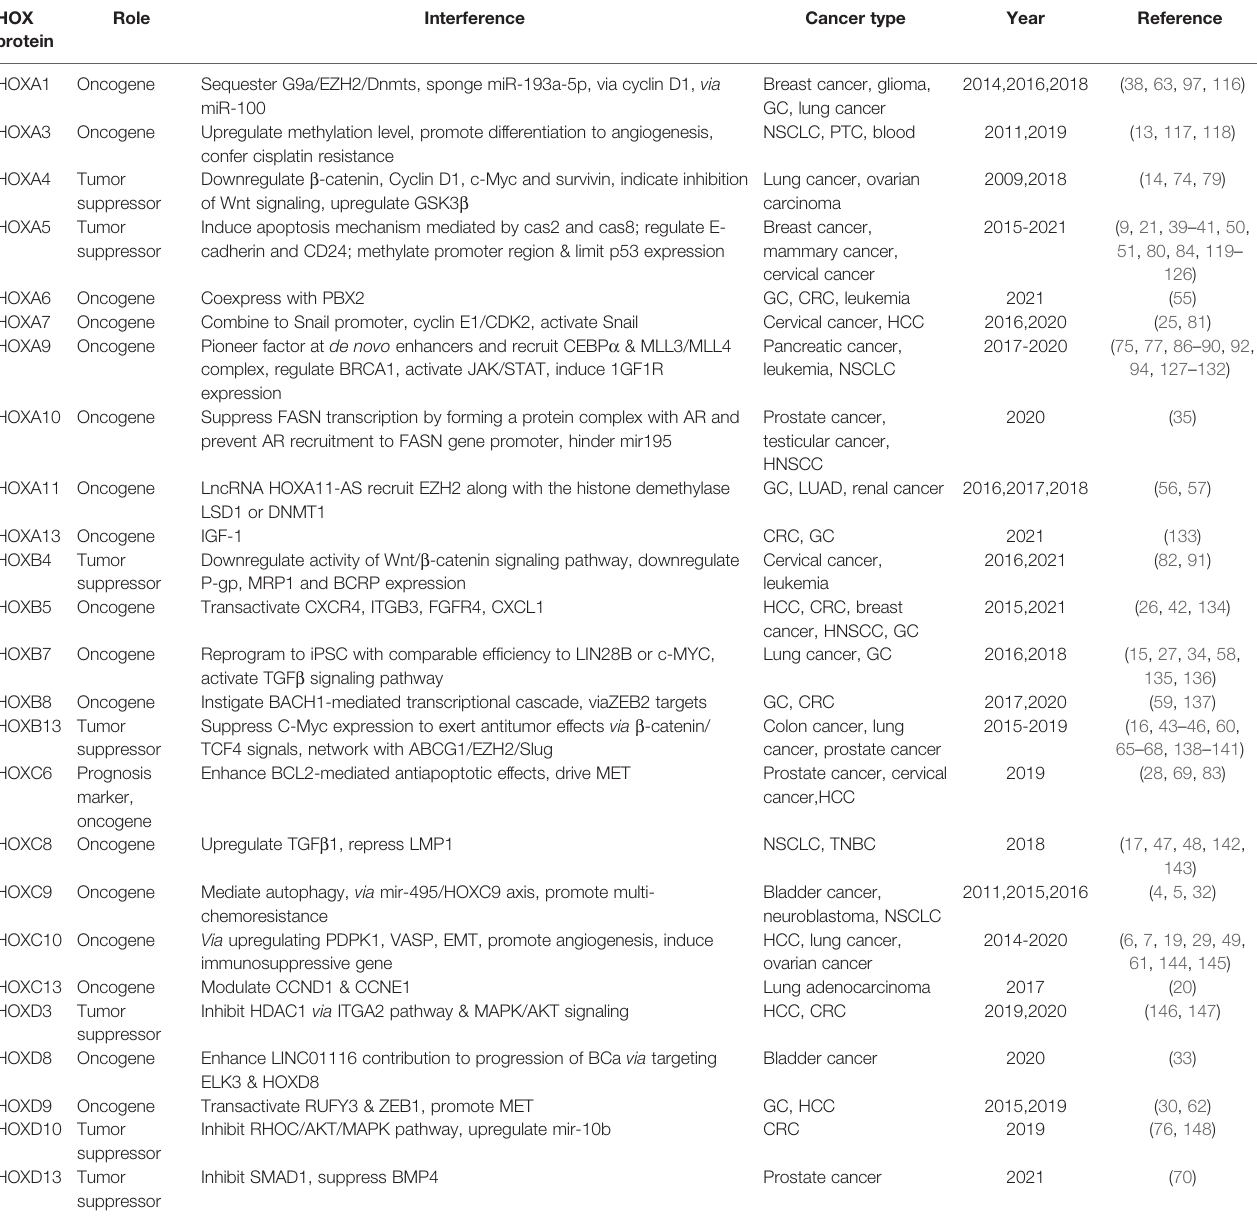
TABLE 1 | Targets identi fi ed for HOX factors in human